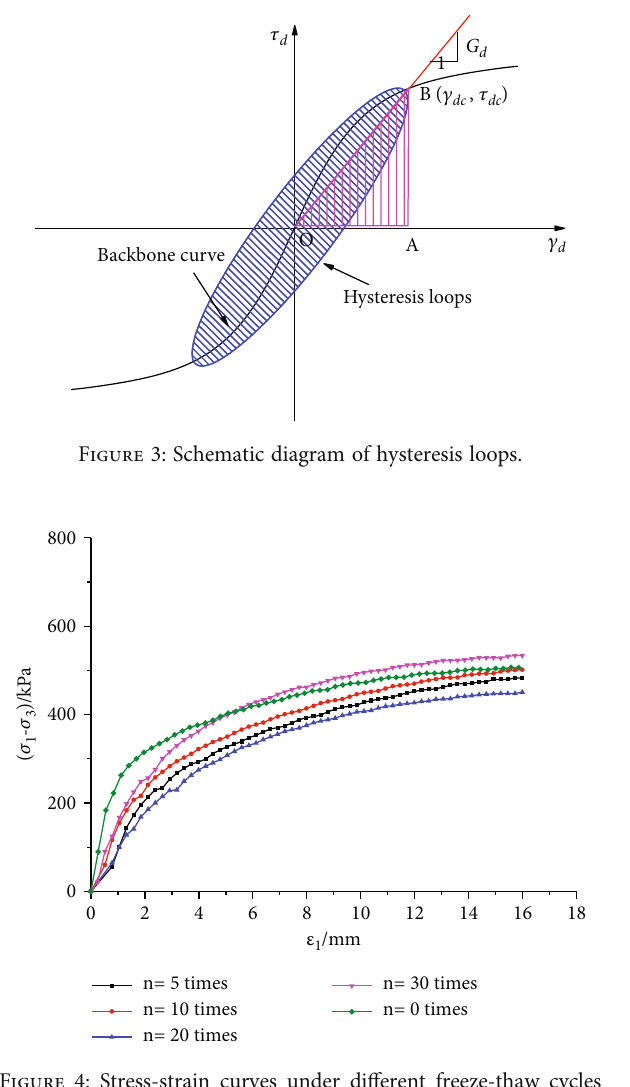
Figure 4: Stress-strain curves under di ff erent freeze-thaw cycles (-5 ° C).